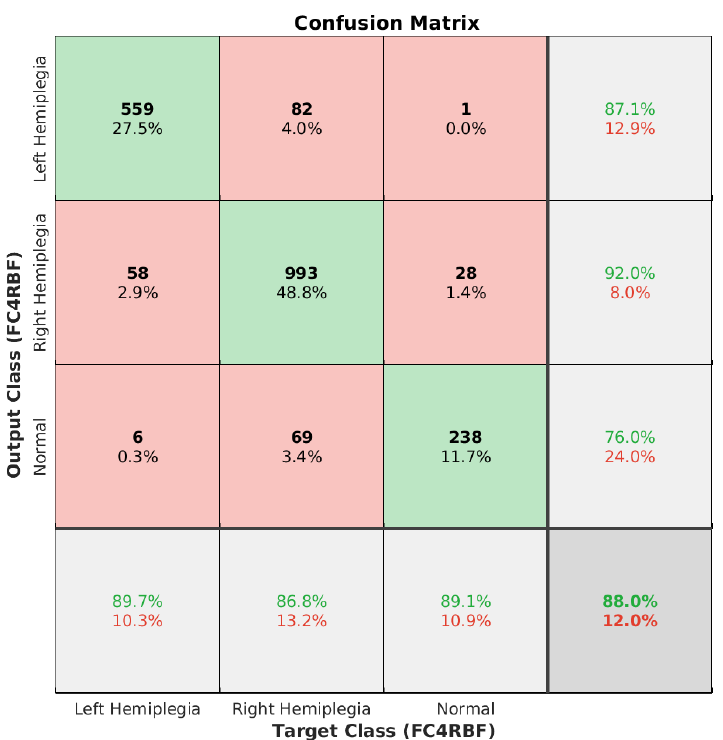
Figure 5. The FC44RBF confusion matrix. The current figure depicts the confusion matrix of the proposed FC4RBF